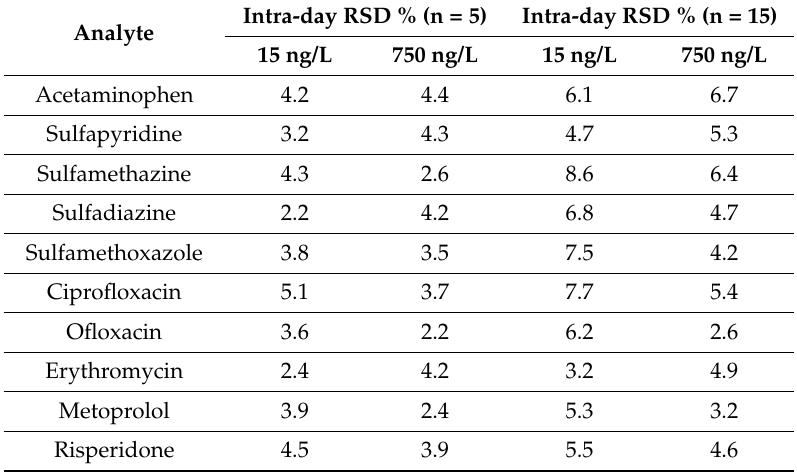
Table 5. The intra- and inter-day precision of the optimized